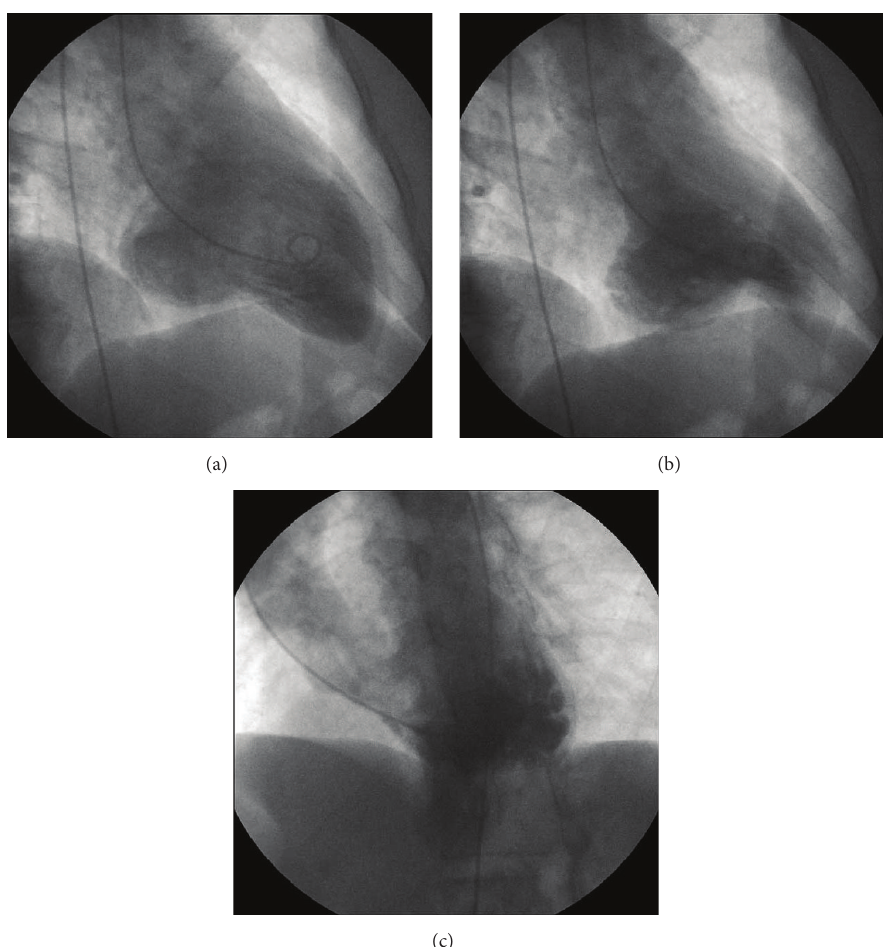
Figure 2: Left ventriculography, showing the mitral subvalvular aneurysm: (a) right anterior oblique, end-diastole; (b) right anterior oblique, end-systole; (c) left anterior oblique,